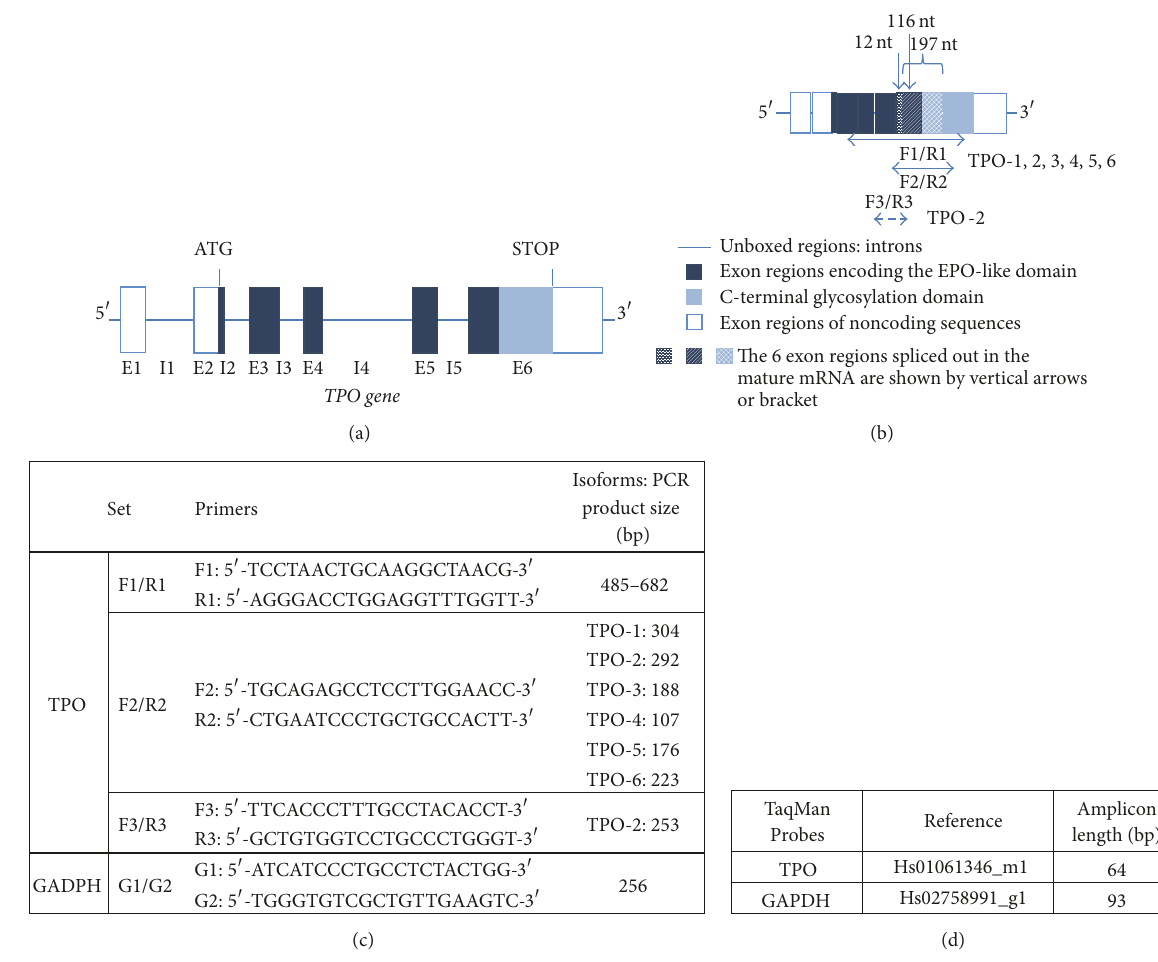
Figure 1: TPO primers’ selection. (a, b) Schematic illustration of human TPO gene and mRNA isoforms and selected TPO primers. (a) TPO gene contains 6 exons (E 1–6) and 5 introns (I 1–5). (b) Alternative RNA splicing patterns previously identified for TPO. Horizontal arrows represent the amplified regions by RT-PCR. (c) Primers used for PCR and nested-PCR. First PCR products were used as DNA template for the nested-PCR. TPO-amplified isoforms and their sizes are shown. GADPH PCR was used as control. (d) TaqMan Probes for TPO and